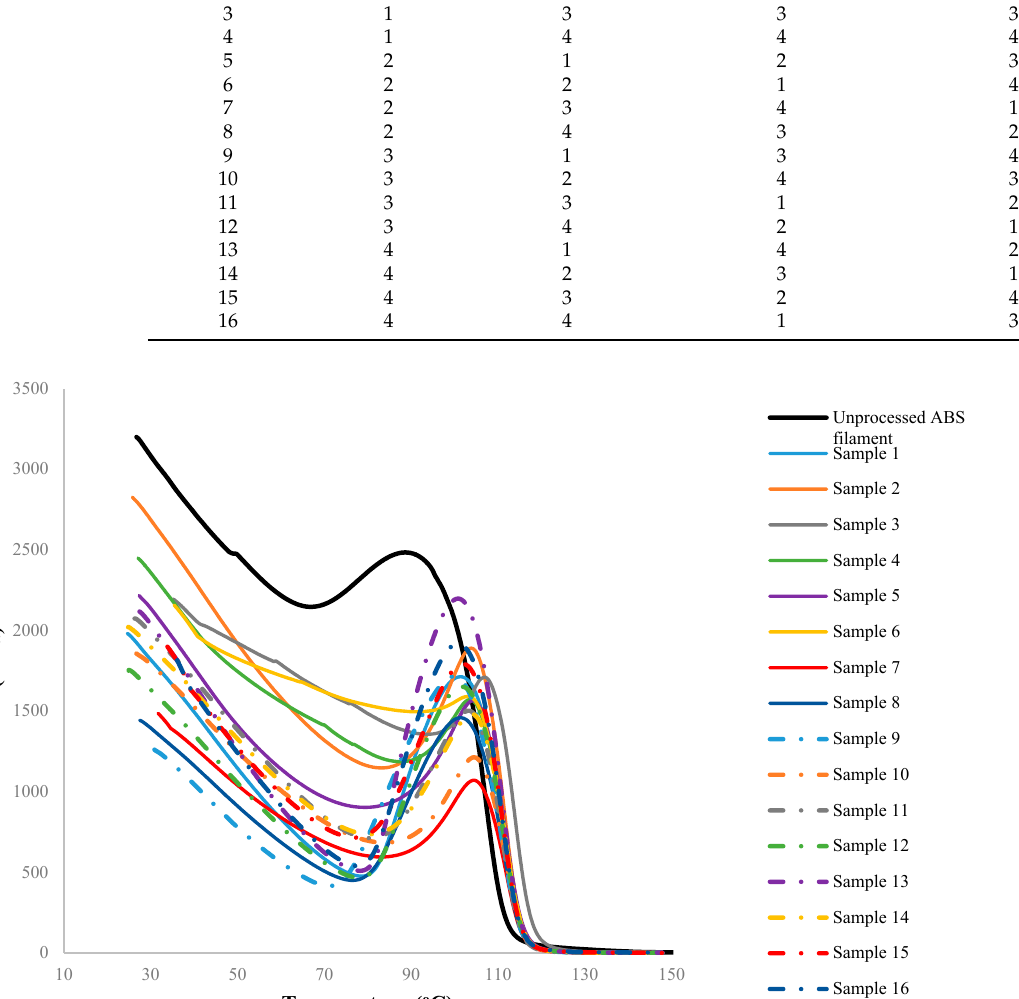
Figure 4. The variation of the storage modulus versus temperature for the test specimens. The overshoot close to glass transition temperature often occurs as the stresses trapped in the part during processing are relieved with an increase in temperature and rearrangement of polymer chains. Note that the sample numbers in the legend correspond to the setups in Table 3, and do not refer to repeats.